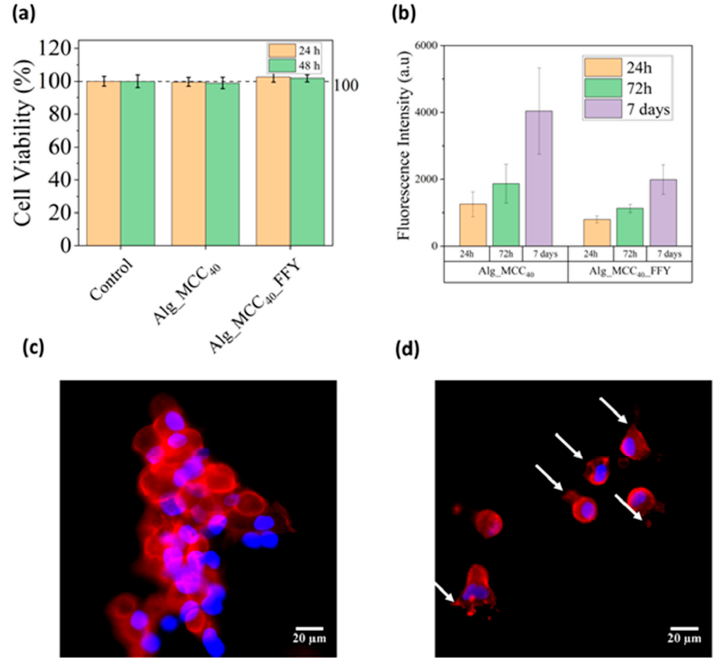
Figure 8. ( a ) The cytotoxicity of the 3D printed scaffolds, Alg_MCC 40 , and Alg_MCC 40 _FFY by the MTT indirect test using MG63 cells. ( b ) Alamar Blue assay. ( c ) Fluorescence images of MG63 cells adhered on Alg_MCC 40 . ( d ) Alg_MCC 40 _FFY printed scaffolds after 72 h. White arrows point to thee adhesive filopodia bridging cell and